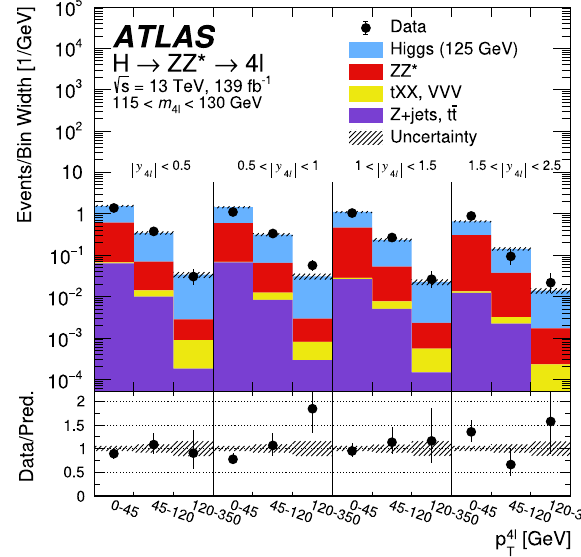
Fig. 10 The observed and expected (pre-fit) distributions of p 4 (cid:3) N jets bins in the mass region 115 < m 4 (cid:3) < 130 GeV, for an integrated luminosity of 139 fb − 1 collected at signal with a mass m H = 125 GeV is assumed. The uncertainty in the prediction is shown by the hatched band, which includes the theoret- ical uncertainties of the SM cross section for the signal and the Z Z ∗ background